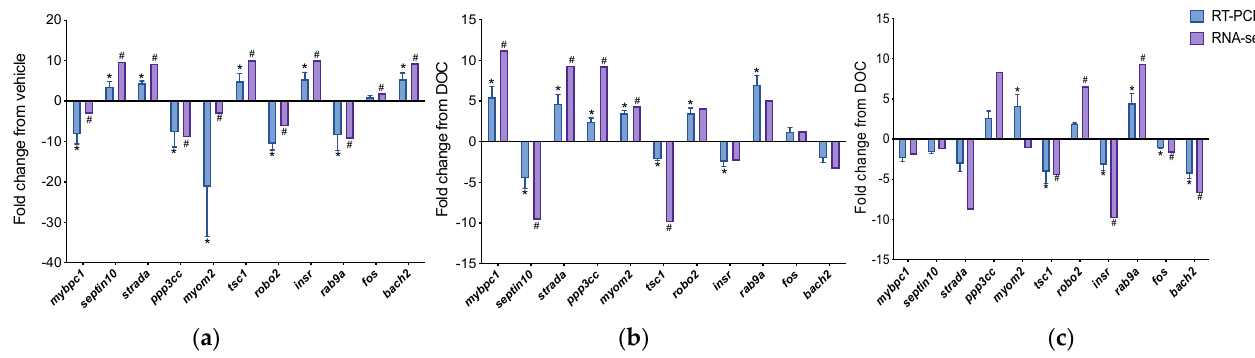
Figure 6. RT-qPCR validation of differentially expressed transcripts. Transcripts selected for the RT-PCR validation of RNA-seq were mybpc1 , septin10 , strada , ppp3cc , myom2 , tsc1 , robo2 , insr , rab9a , fos , and bach2 . ( a ) Validation between vehicle and DOC; ( b ) validation between DOC and DOC plus mifepristone; ( c ) validation between DOC and DOC plus eplerenone. For RNA-seq, in purple, “#” indicates a log2 fold change ≥ 2.0 and FDR <0.05. For RT-qPCR, in blue, relative expression was normalized against fau and act β , and “*” indicates significant differences in fold change from vehicle or DOC groups (mean ± SEM, n = 4, p < 0.05). Abbreviations: mybpc1, myosin-binding protein C1; strada, STE20-related kinase adapter protein α ; ppp3cc, calcineurin; myom2, myomesin 2; tsc1, TSC complex subunit 1a; robo2, roundabout homolog 2; insr, insulin receptor; rab9a, ras-related protein Rab-9A; fos, proto-oncogene c-Fos; bach2, BTB domain and CNC homolog 2; fau, 40S ribosomal protein S30; act β , β